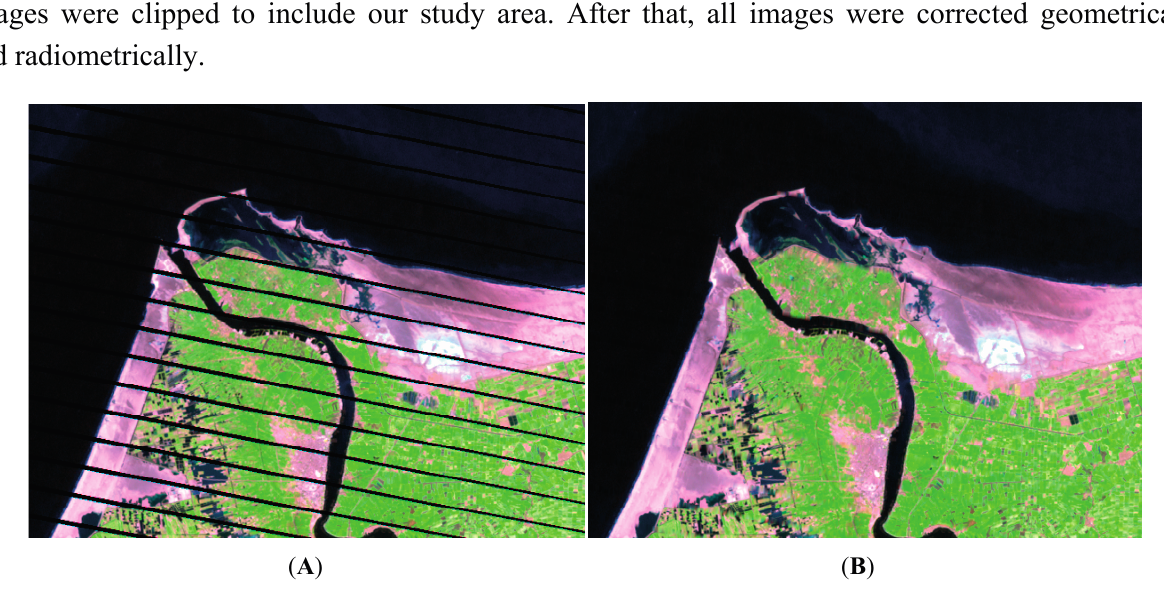
Figure 2. ( A ) Landsat image (2005) before striping removal; and ( B ) after striping